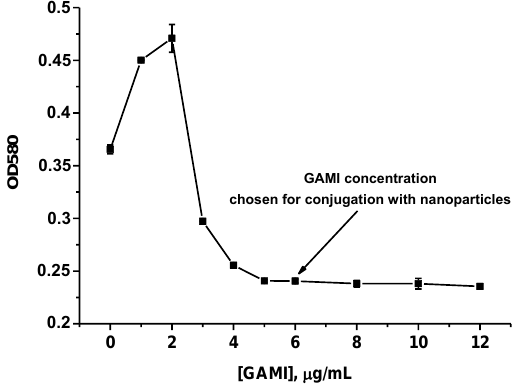
Figure 2. GAMI flocculation curve.